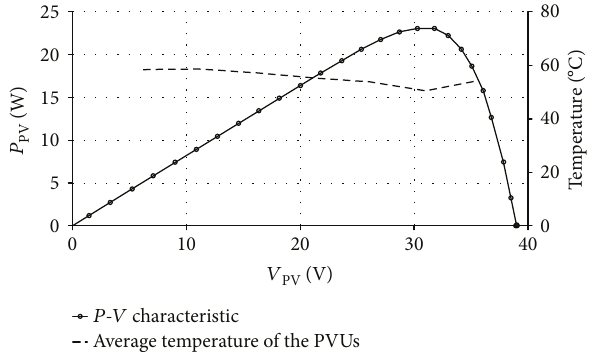
Figure 4: P - V characteristic of the two series-connected PVUs and average temperature of the two PVUs as a function of the operating voltage. 26 September 2017, Aversa (CE), Italy. S = 600W/m 2 and ambient temperature T amb = 25 ° C